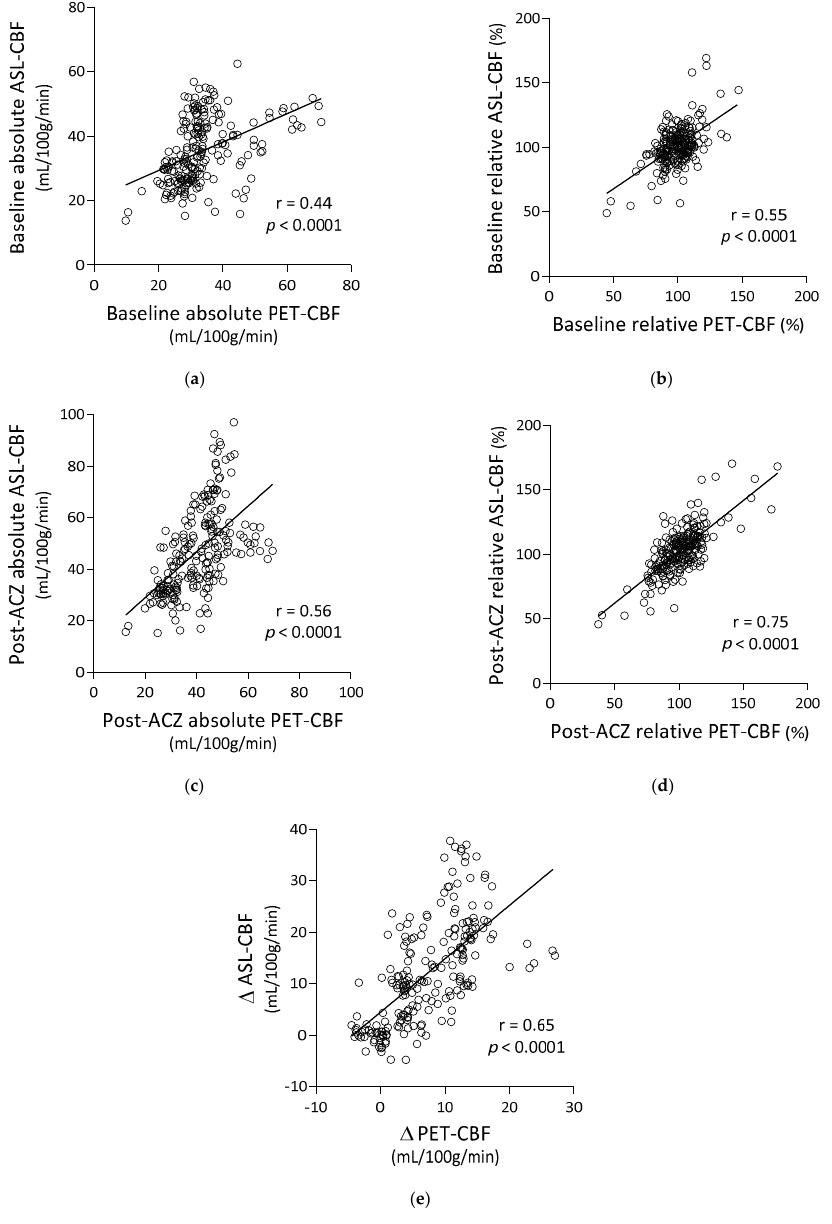
Figure 3. Correlation between PET ‐ CBF and ASL ‐ CBF. ( a ) Pre ‐ ACZ absolute PET ‐ CBF and ASL ‐ CBF, ( b ) pre ‐ ACZ relative PET ‐ CBF and ASL ‐ CBF, ( c ) post ‐ ACZ absolute PET ‐ CBF and ASL ‐ CBF, ( d ) post ‐ ACZ relative PET ‐ CBF and ASL ‐ CBF, ( e ) differences in ASL ‐ CBF ( Δ ASL ‐ CBF) and PET ‐ CBF ( Δ PET ‐ CBF) between baseline and post ‐ ACZ states. Regression lines are shown with Pearson’s correlation coefficients (r) and associated p ‐ values.